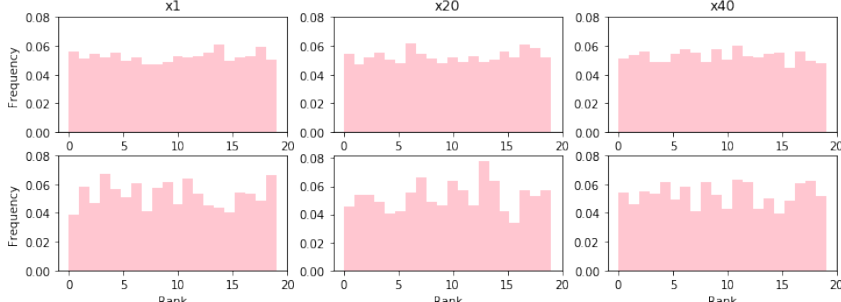
Figure 6. Rank histogram with adaptive localization (line 1) and no localization (line 2), the three columns represent the 1st, 20th and 40th model variables, respectively.